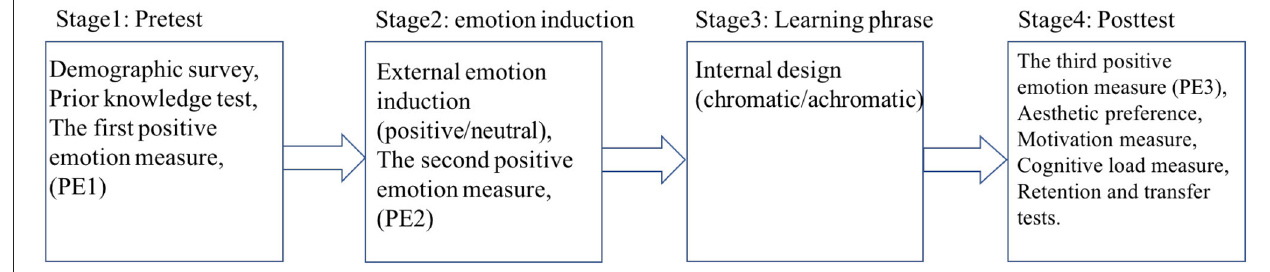
FIGURE 3 | Procedure of the formal experiment.